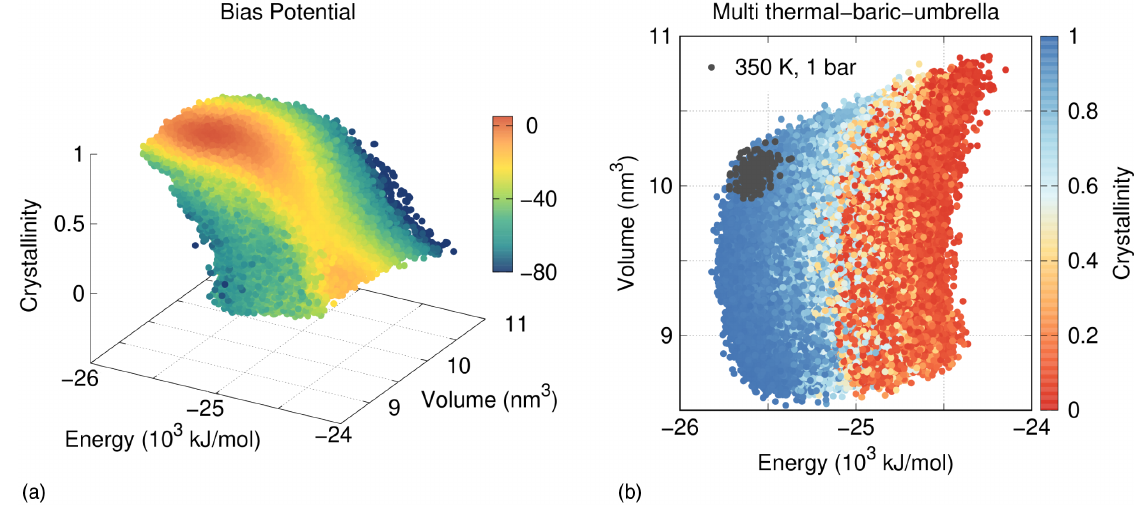
FIG. 6. Configurations of sodium sampled during the multithermal-multibaric-multiumbrella simulation. (a) The points are colored accordingly to the value of the bias v ð U; V; s Þ . (b) The points are shown in the energy-volume space and colored accordingly to the value of the crystallinity CV s . As reference we also show in gray the region sampled during an unbiased simulation in the bcc